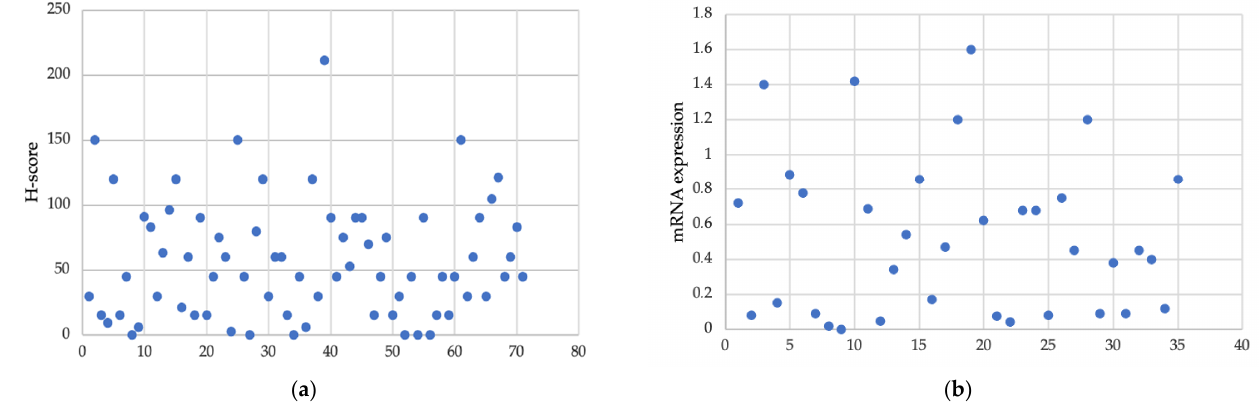
Figure 3. Distribution of VISTA H-score and VISTA mRNA expression in the group. ( a ) H-score level in the group of 71 patients. ( b ) mRNA expression in the group of 35 patients. Table 1. The impact of different factors on VISTA H-score (protein) level. Clinical characteristics of the 71-patient group with H-score.